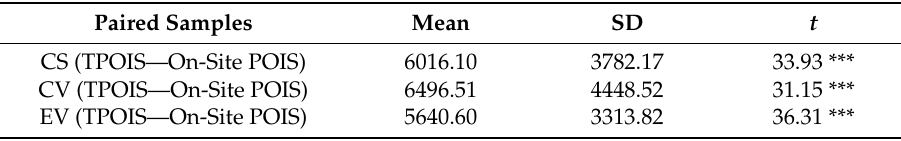
Table 9. Results of paired-sample t -test for the two